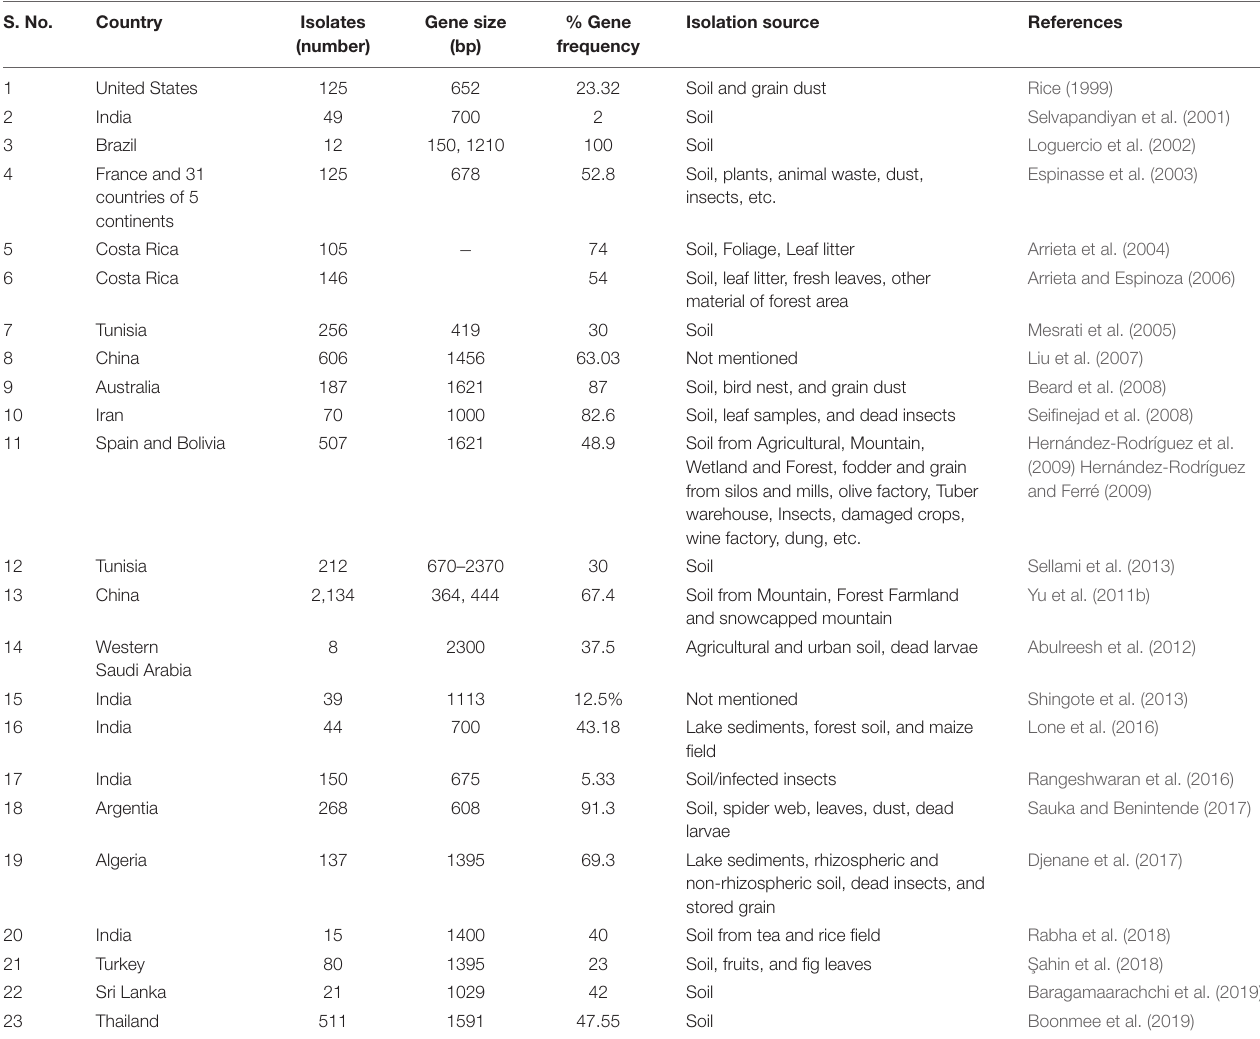
TABLE 2 | vip3 -type gene distribution in Bt isolates from different countries. S.